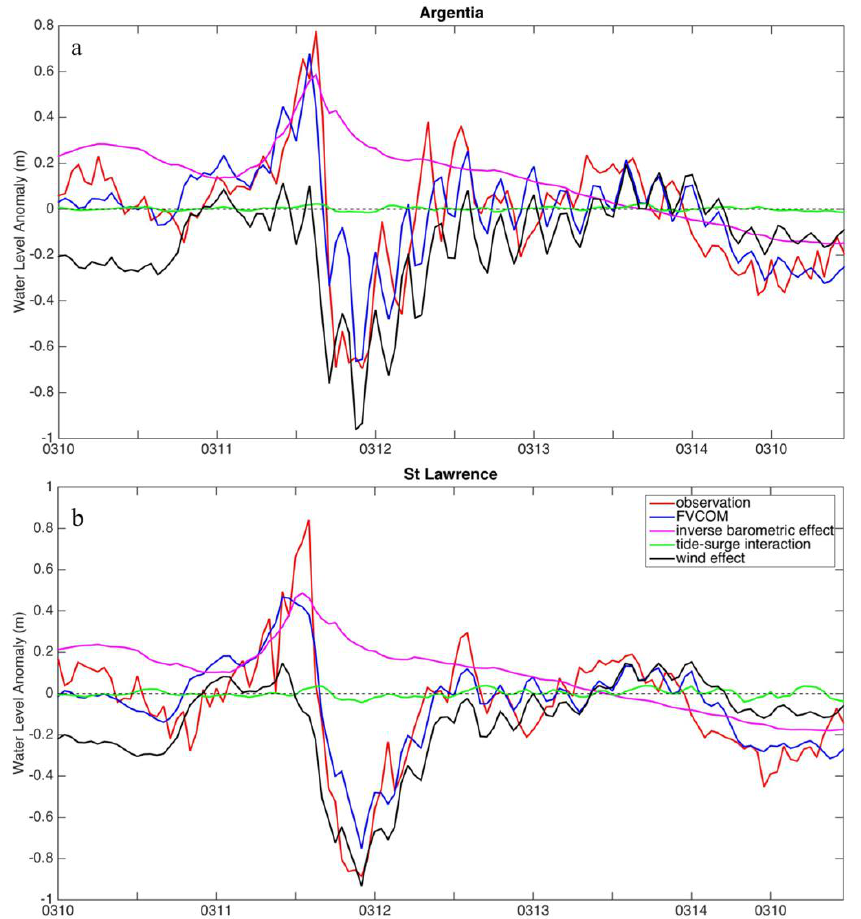
Figure 11. Time series of the non-tidal sea level anomalies (m) from observations (red) and model results (blue), the inverse barometric effect (purple), the tide-surge interaction (green), and the wind effect (black) at AG ( a ) and SL ( b ).